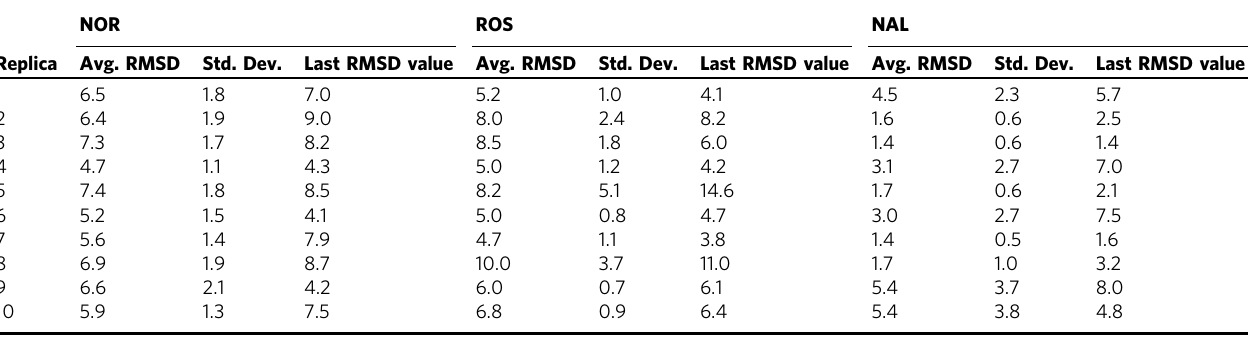
Table 2 RMSD values of NOR, ROS and NAL. RMSD values (in Å) for the 10 replicas of the three quinolones NOR, ROS and NAL were obtained using the fi rst frame of the trajectory as reference.